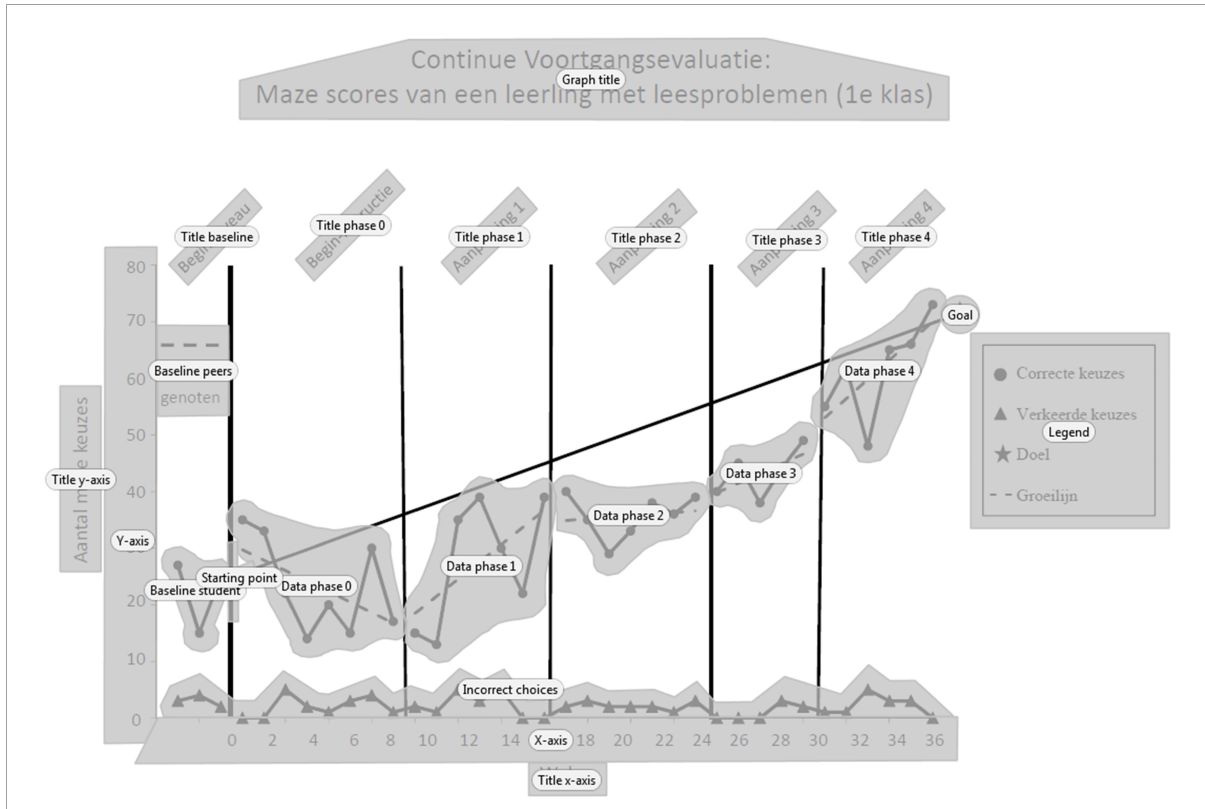
FIGURE2 Sample CBM graph with the following AOIs (as depicted by the shaded areas): Framing (i.e., graph title, titles axes, x- and y-axis, legend), Baseline (i.e., title, data student, data peers), Starting point (begin point goal line), Instructional phases 0–4 (i.e., titles, data points, and slope lines), Incorrect choices (triangles at bottom of graph), and Long-range goal (end point goal line). Figure adapted from Wagner et al.